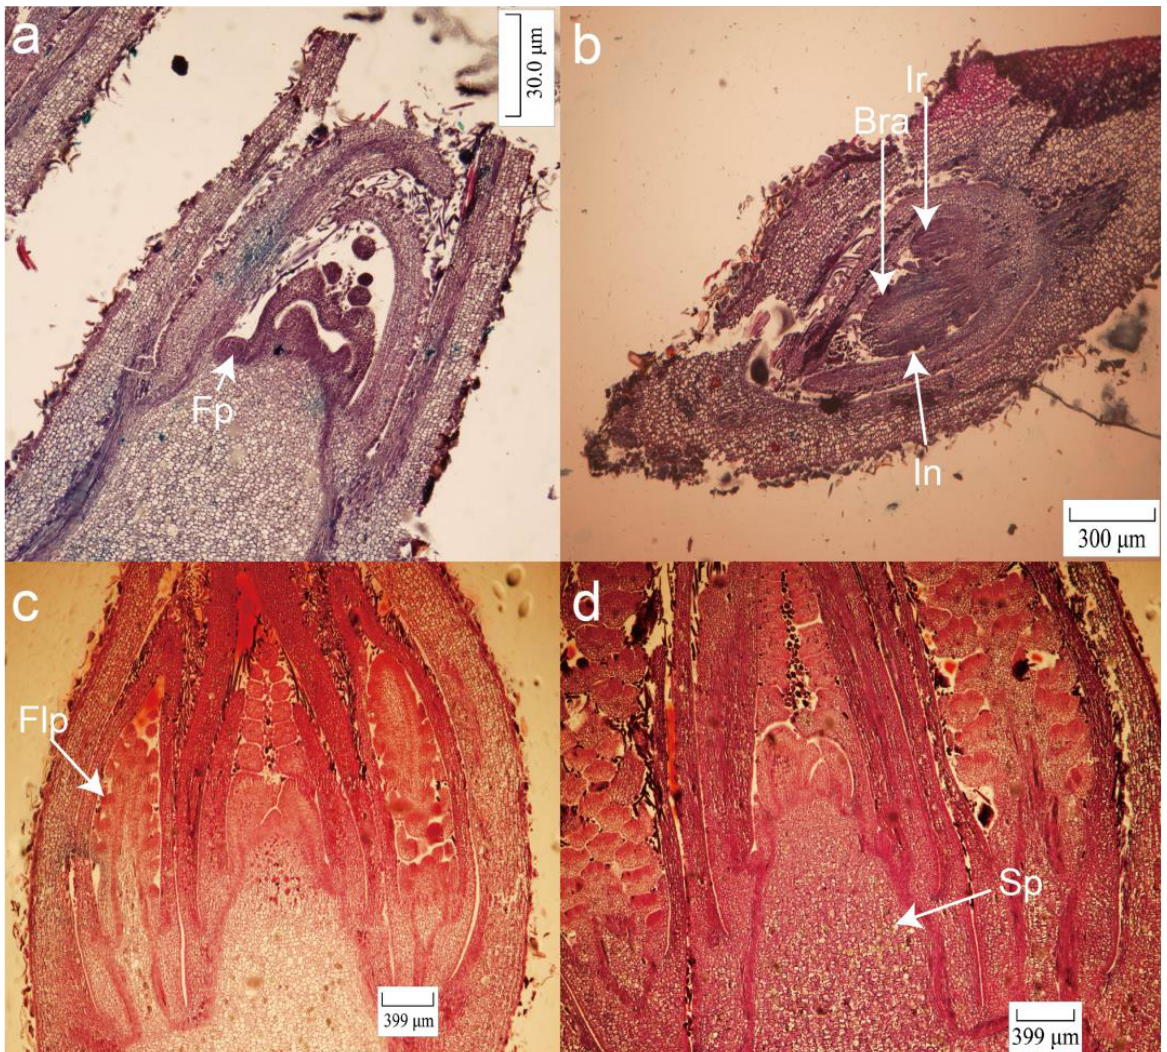
Figure 1. Morphological characteristics of pecan male flower bud differentiation. ( a ) The early stage of male flower bud differentiation (MD1) with flower primordia (Fp) can be observed in late April. ( b ) Male flower primordia with involucre (In), bract anlage (Bra), and inflorescence rachis (Ir) were observed from early until mid-May (MD2). ( c ) Floret primordia (Flp) also appeared in sequence with the elongation of the male inflorescence and increased the number of bracts in early July. ( d ) The stamen primordium (Sp) appeared in the middle of the male flower primordium depression after the calyx primordium differentiated in late July (MD3).